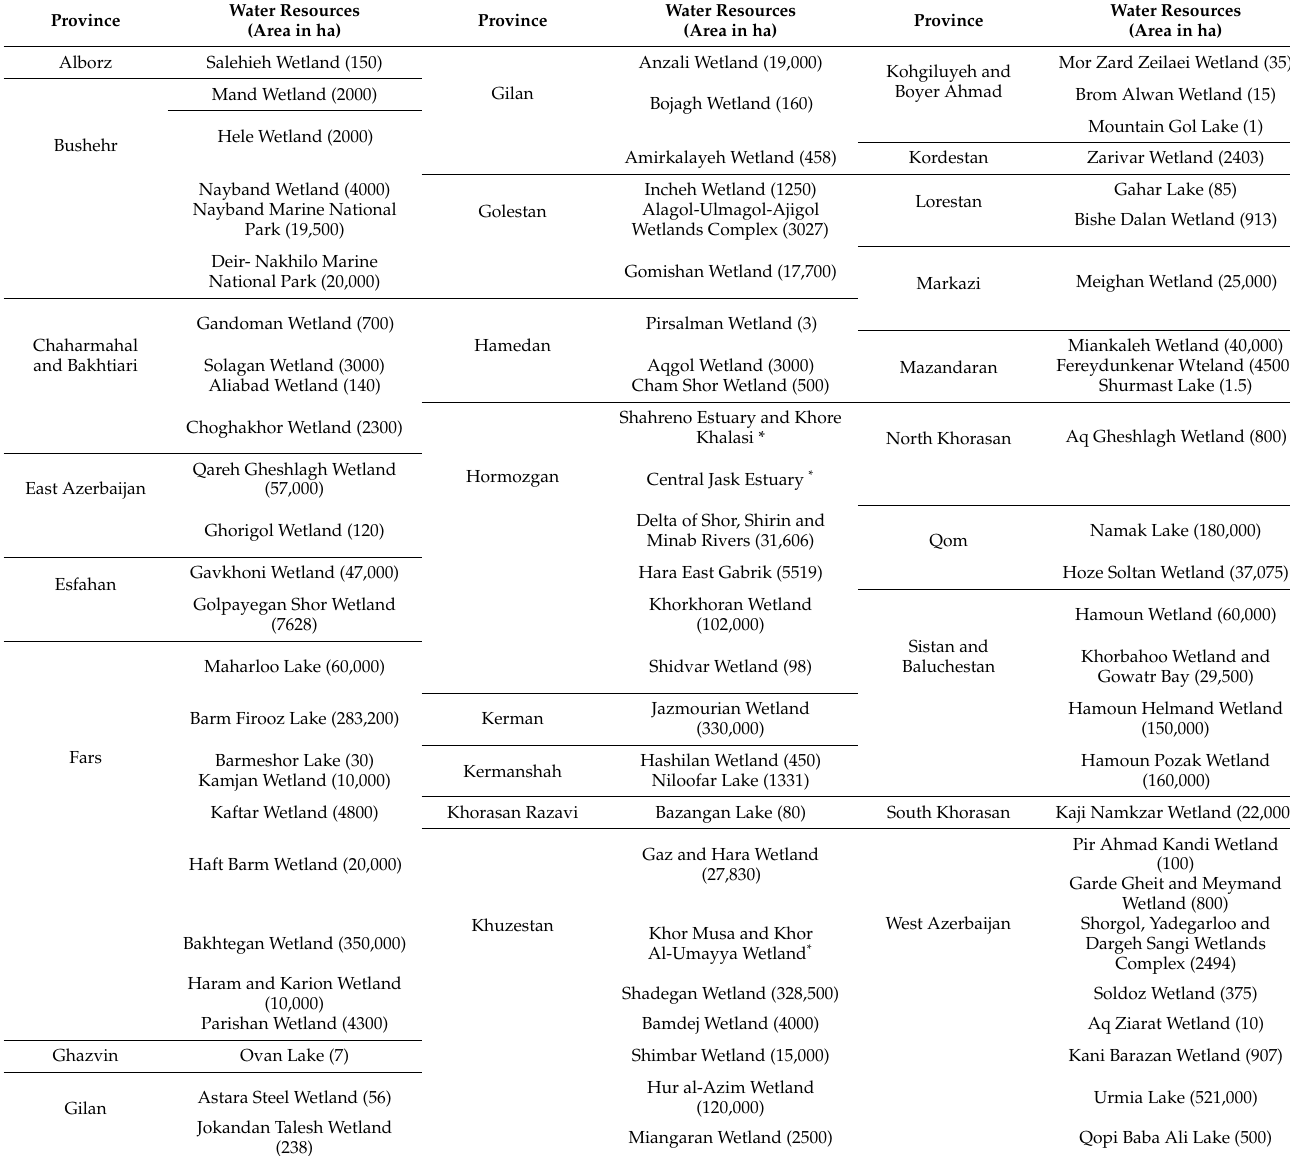
Table A1. List of the most important water resources in the studied